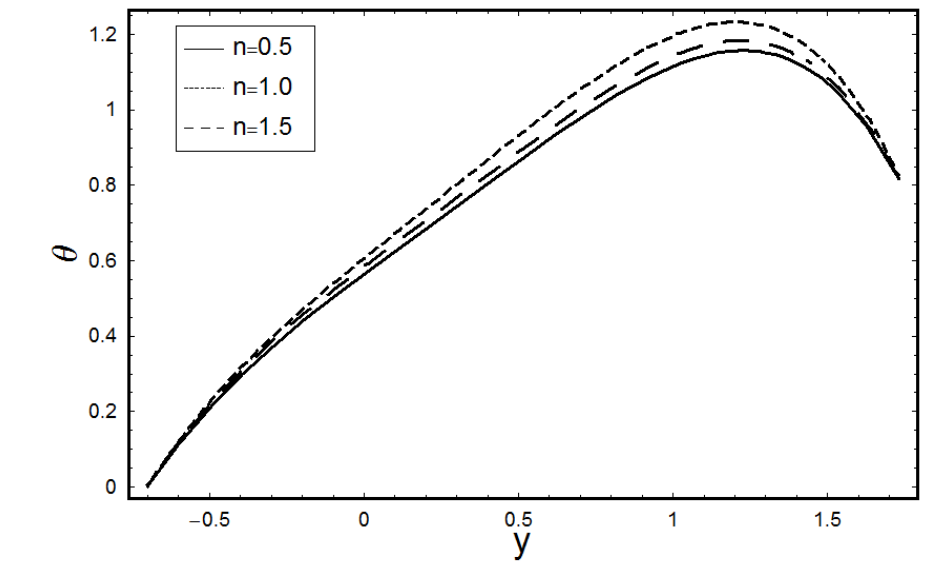
Figure 14. Variation in θ for n with a = 0.3, b = 0.3, d = 0.6, φ = π /4, Θ = 1, x = 0, b ∗ = 0.2, Br = 0.5, Bi 1 = 1 and Bi 2 =